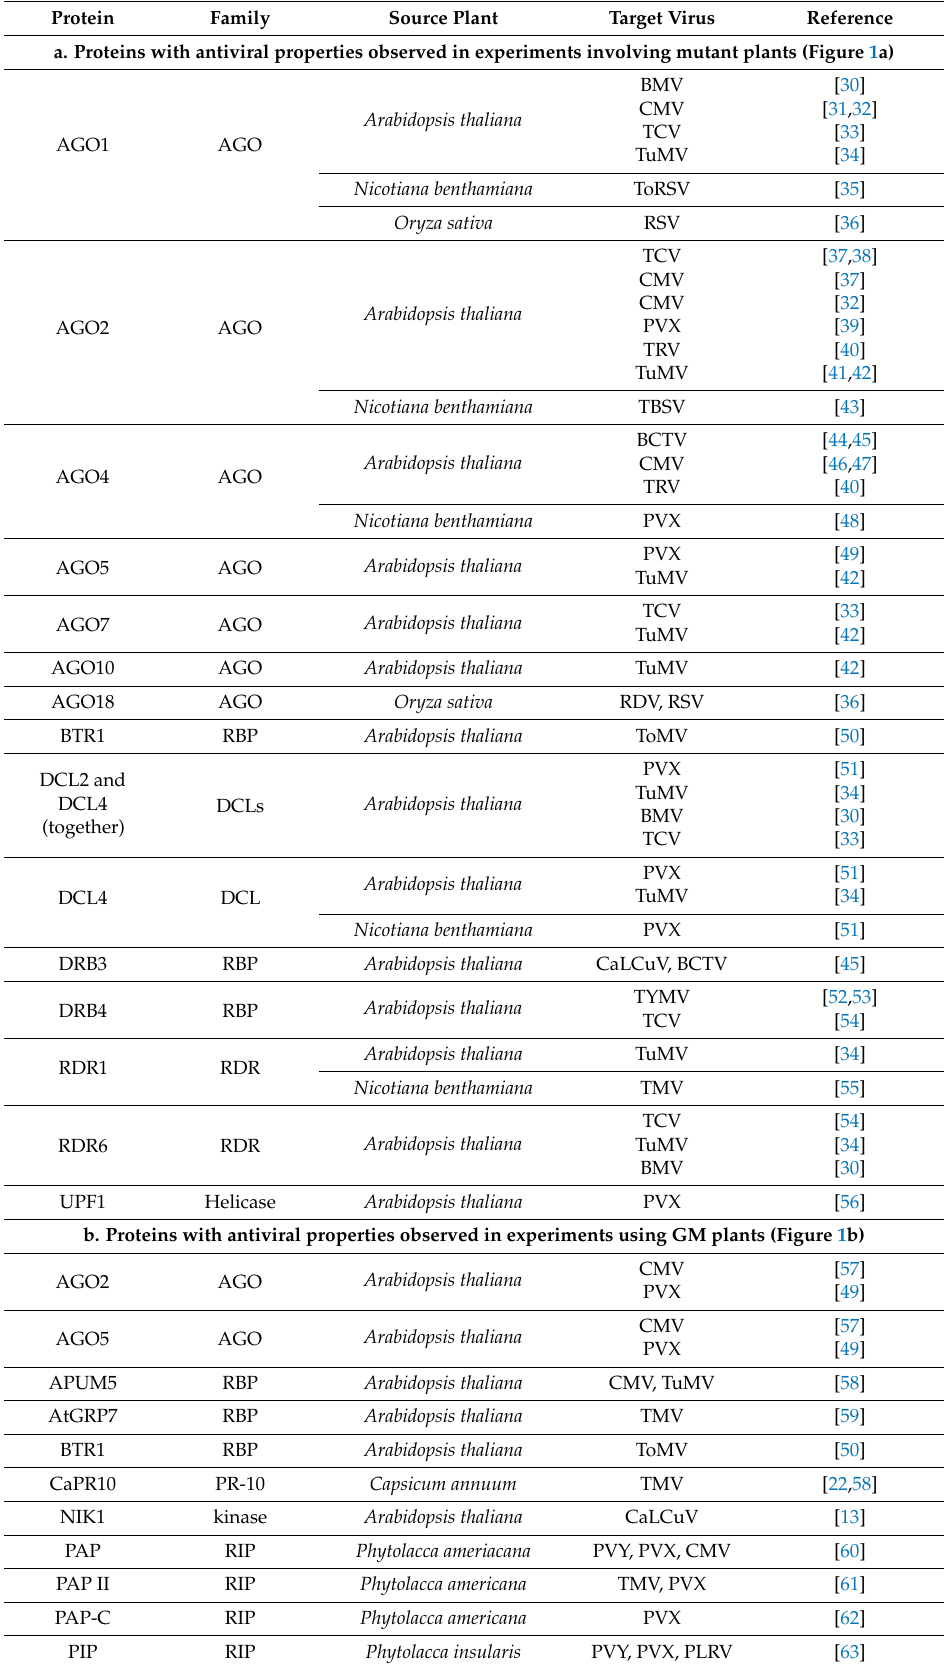
Table 1. List of plant proteins with antiviral activity confirmed in different sets of experiments. Protein Family Source Plant Target Virus